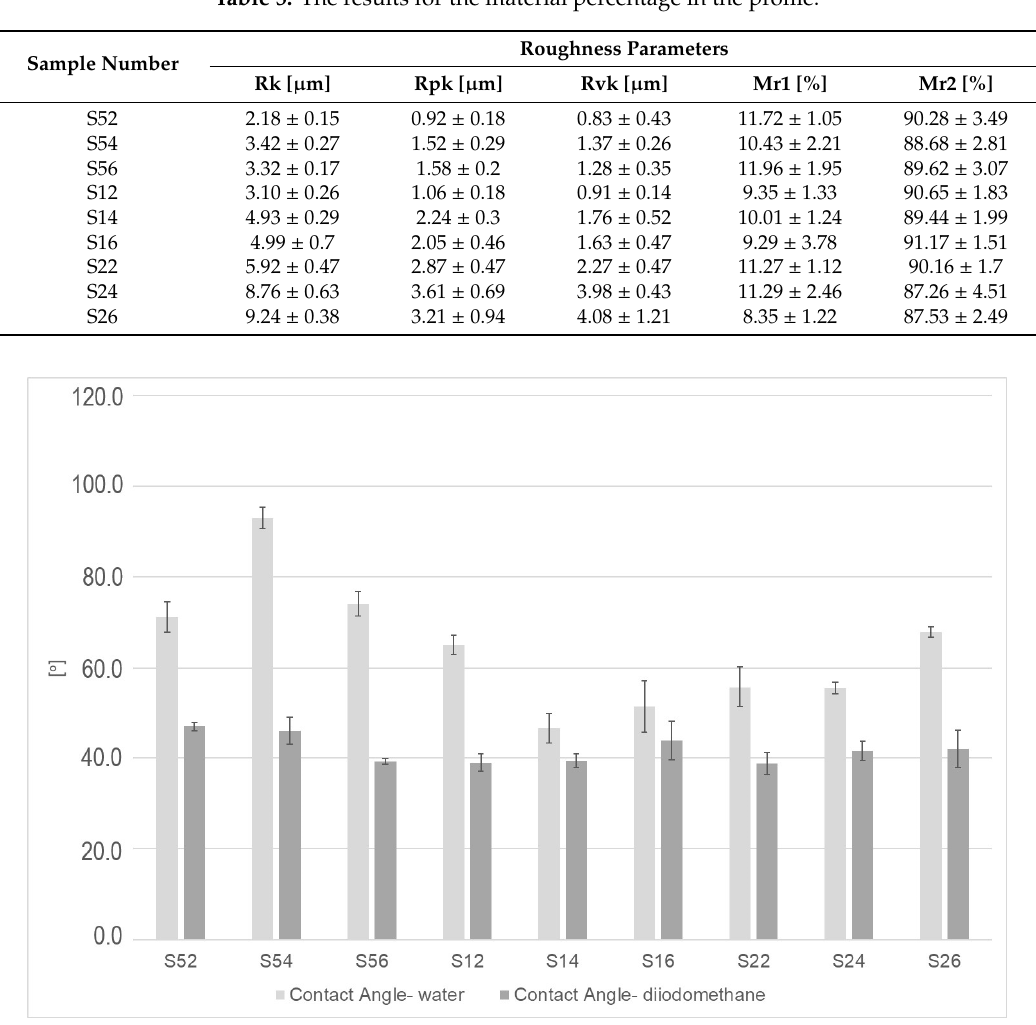
Figure 5. Graph presenting water and diiodomethane wetting for the surface after SiC processing.